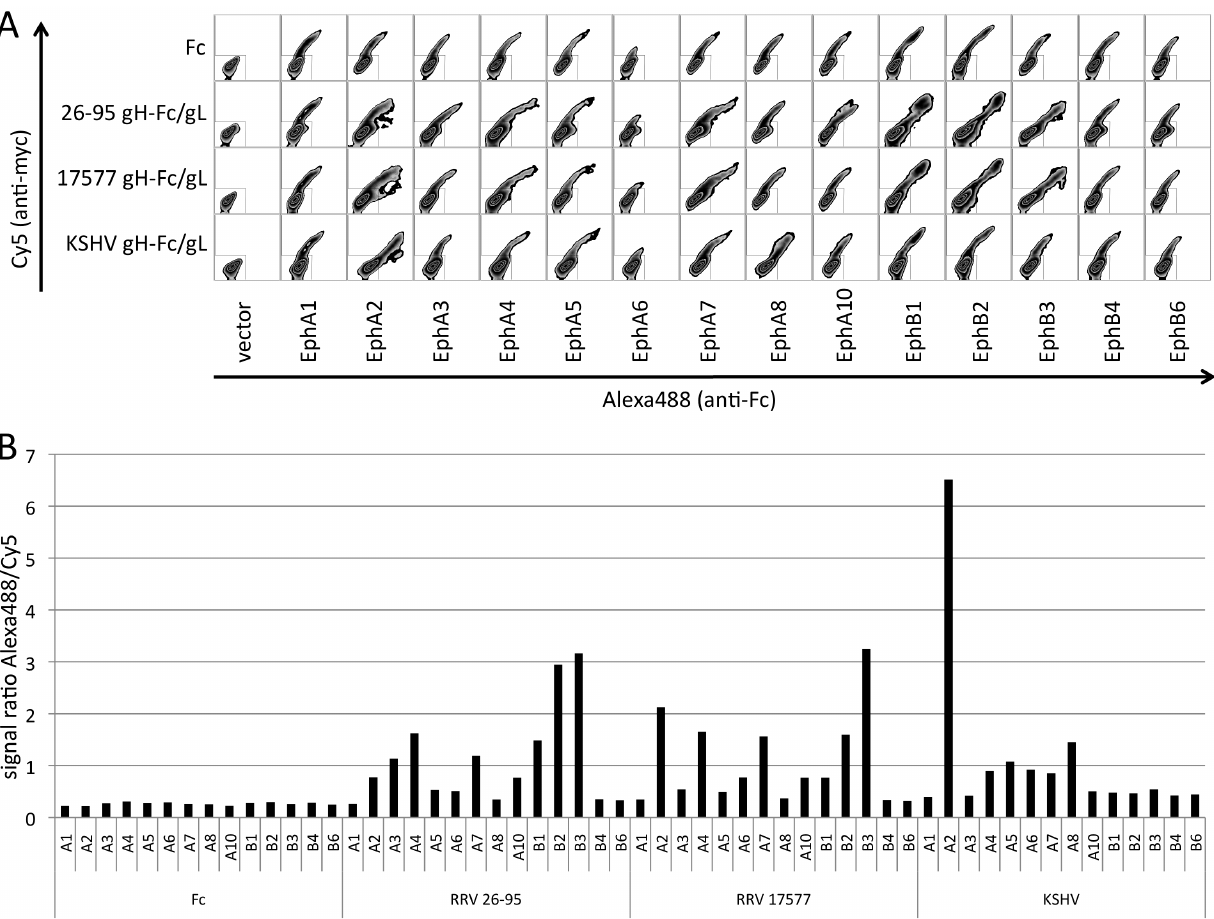
Figure 2. Interaction of rhadinoviral gH/gL complexes with Eph family receptors. ( A ) Binding of soluble gH-Fc/gL complexes to Eph family proteins. 293T cells were transfected with the indicated myc epitope-tagged Eph constructs. The cells were fixed and permeabilized, and both Eph expression and binding of soluble gH-Fc/gL complexes from RRV 26-95, RRV 17577 or KSHV at 10 nM was assayed by flow cytometry. Fc was used as a control. ( B ) As a semi-quantitative gauge of binding, the ratio of the geometric mean fluorescence intensities for Eph-expression and gH-Fc/gL binding was calculated. The whole area of the dot blot containing cells positive for Cy5 and/or Alexa488 except for the box gate containing negative cells in the lower left corner was analyzed, and the ratio of the geometric mean of the fluorescence intensity (MFI) for bound gH-Fc/gL (Alexa488) over the MFI for Eph expression (Cy5) was calculated. Values for the Fc control protein are shown to the left and represent the assay background.